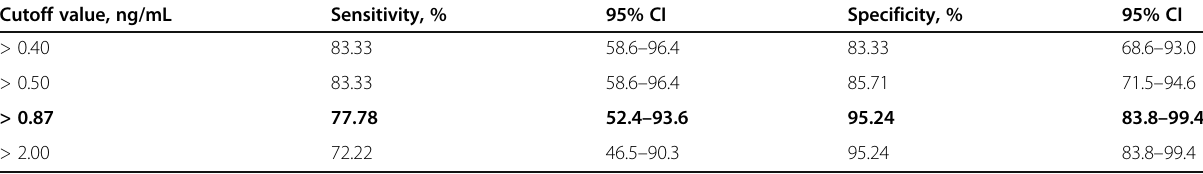
Table 4 Sensitivity and specificity as cutoff value of procalcitonin for the diagnosis of sepsis syndrome of maxillofacial infection Cutoff value,